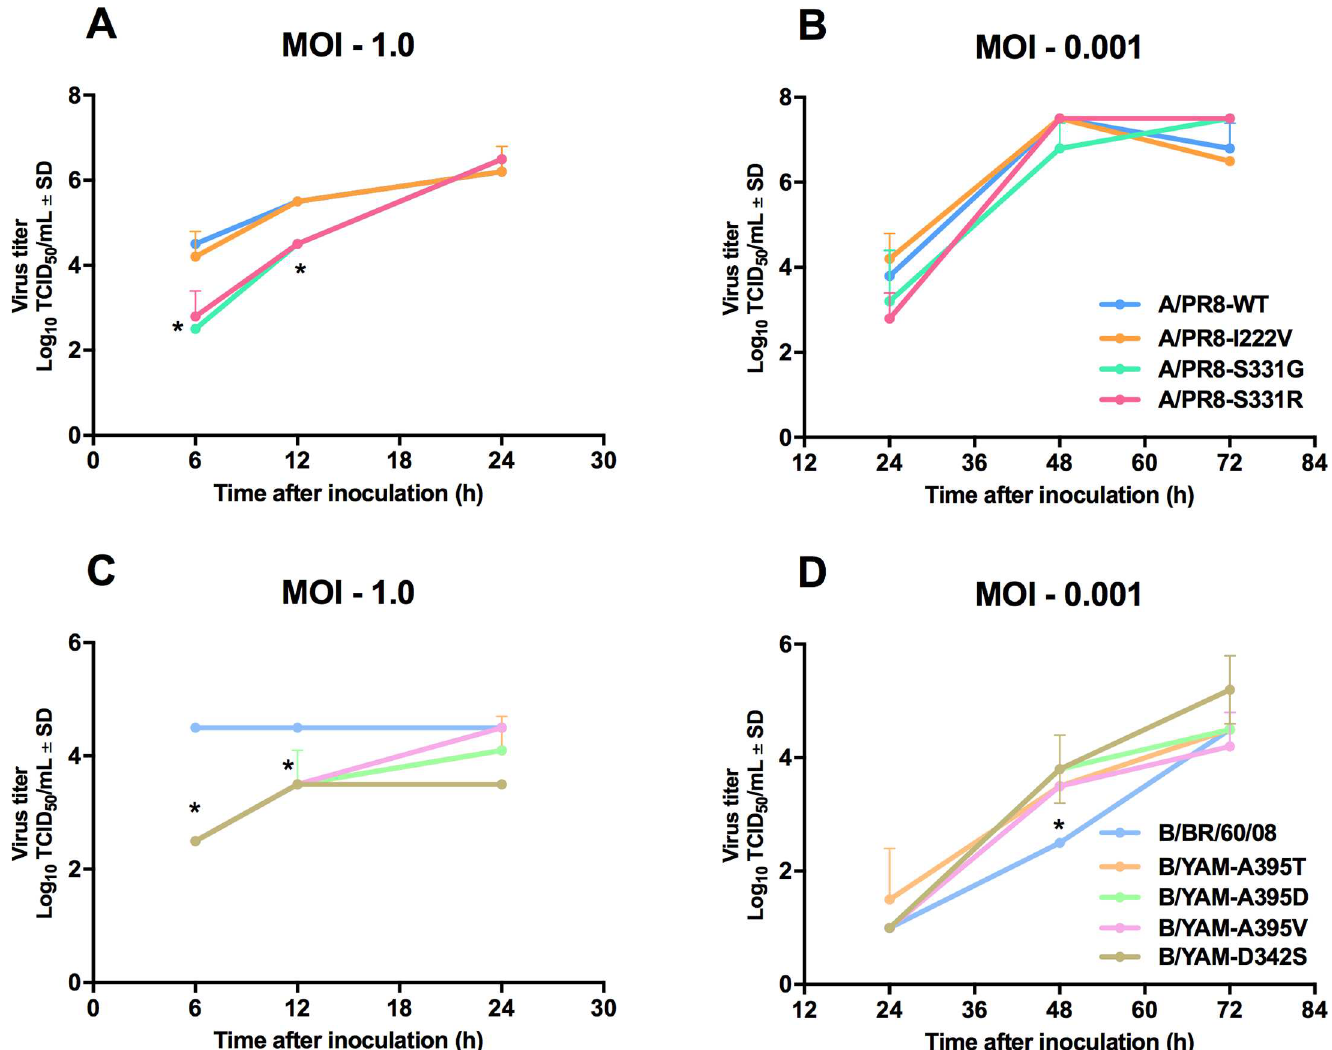
Fig 2. Replication kinetics in MDCK cells of recombinant influenza A and B viruses carrying a single NA amino acid substitution. MDCK cells were infected with recombinant influenza A and B viruses at an MOI of 1 (A, C) or 0.001 (B, D). Virus titers were determined by TCID 50 assays in MDCK cells after incubation for 72 h at 35˚C (for influenza A viruses) or 33˚C (for influenza B viruses). Each data point represents the mean virus titer (log 10 TCID 50 /mL) ± the SD from three independent experiments. (cid:3) P < 0.05.